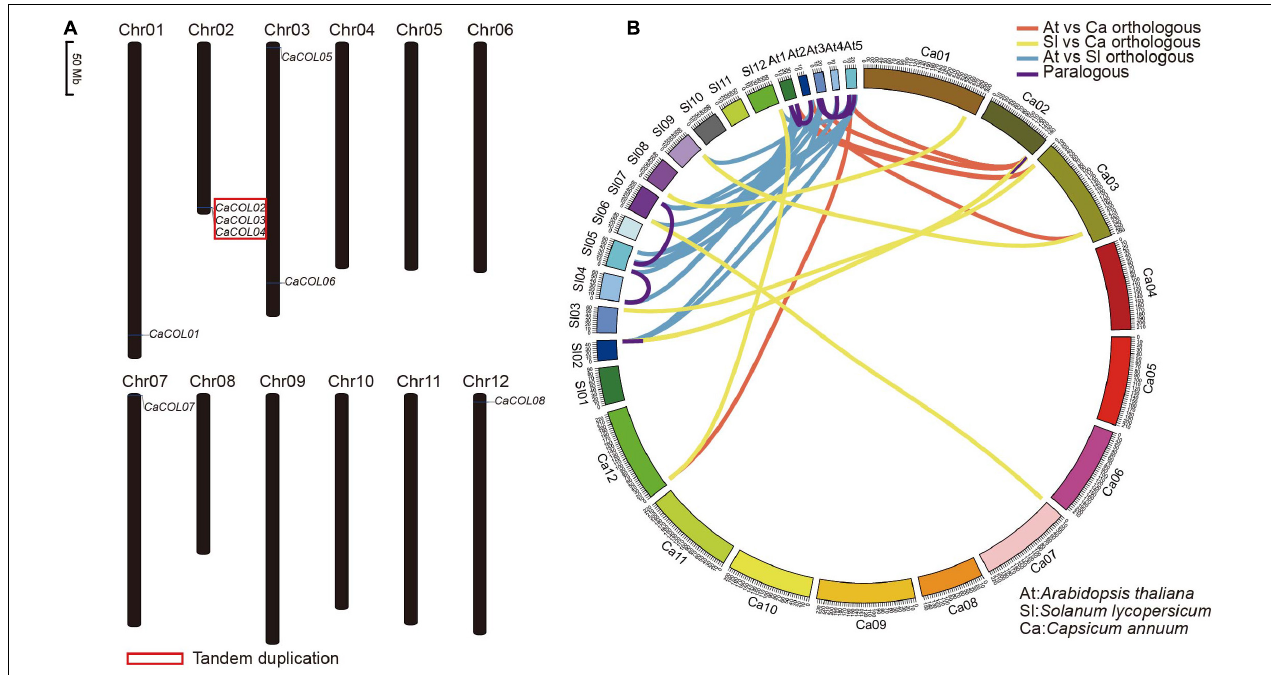
FIGURE 4 | Chromosomal localization of CaCOL genes (A) and the relationship of COL homologous genes among Capsicum annuum , Solanum lycopersicum , and Arabidopsis thaliana (B) . The red box indicates tandem duplicated genes. Lines showing orthologous gene pairs between A. thaliana and C. annuum are red; those between S. lycopersicum and C. annuum are yellow; and those between A. thaliana and S. lycopersicum are blue. Lines showing paralogous gene pairs are